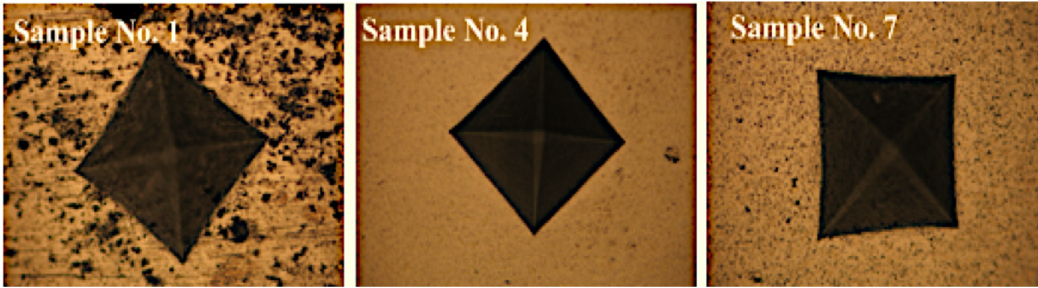
Figure 8. Hardness indentation of the investigated ODS reinforced tungsten heavy alloys (WHAs).